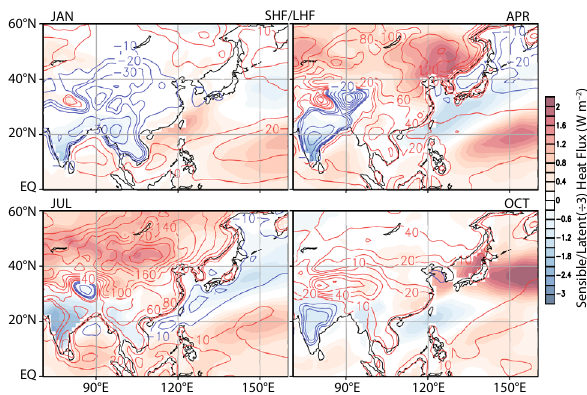
Fig. 9 The patterns of anomalous sensible heat flux over the conti- nent and anomalous latent heat flux (÷ 3) over the ocean (shade; W m −2 ) together with the change in maximum boundary layer height (blue < 0 < red contour lines at ± 10, 20, and at 20 m interval thereaf- ter) for the warming